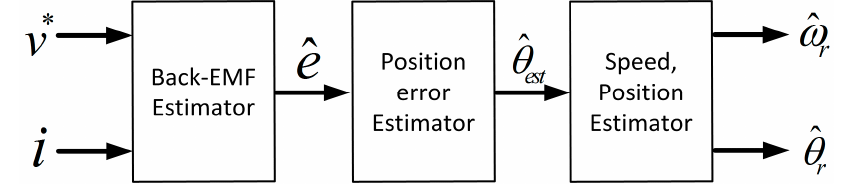
Figure 1. Back-EMF based sensorless method system configuration.